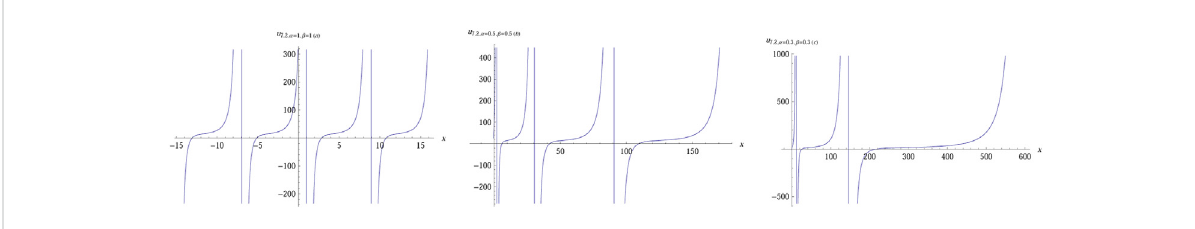
FIGURE 11 Changes in the waveform of u 7 . 2 with different values of α , β